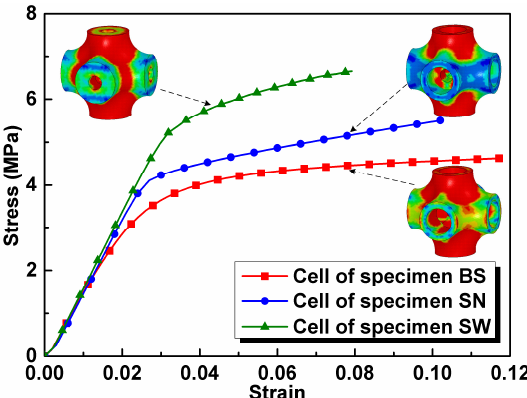
Figure 5. Stress-strain curves of the different cells obtained by numerical simulation.